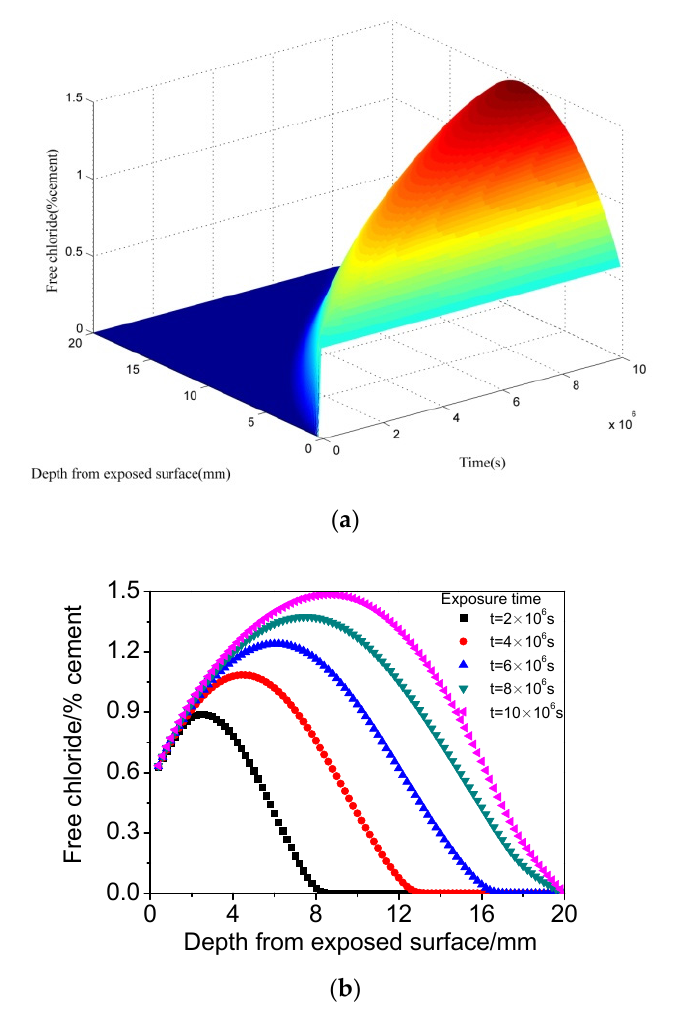
Figure 4. The calculated chloride distribution of concrete subjected to cyclic wetting–drying condi- tions when the CO2 concentration is 20.0%. ( a ) Three dimensions. ( b ) Two dimensions.